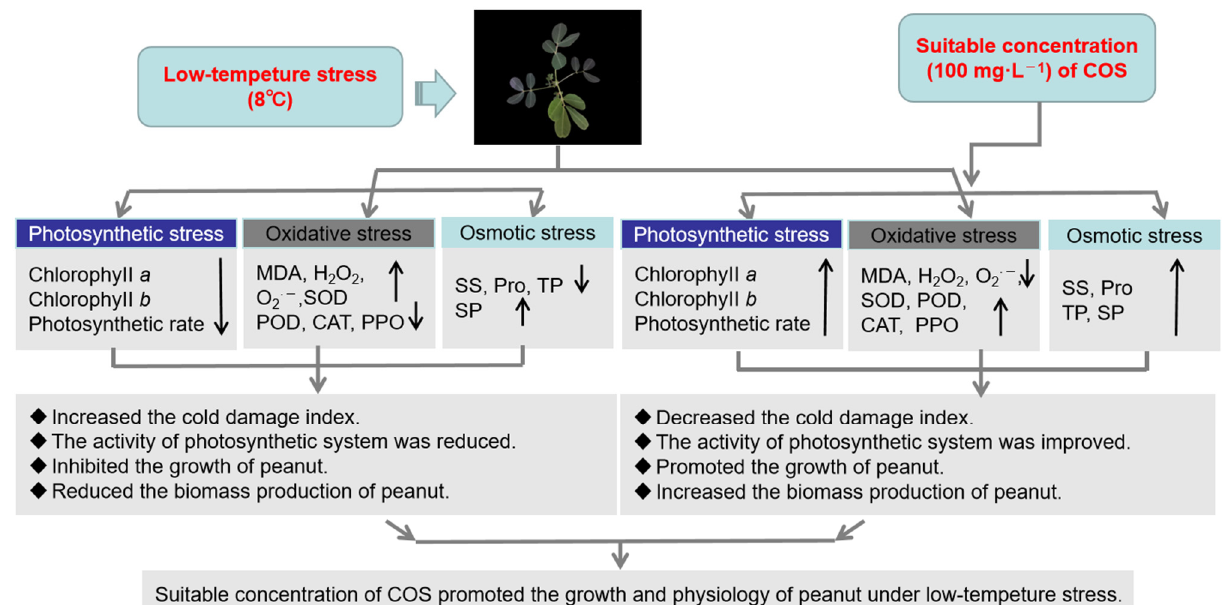
Figure 6. Summary changes of physiological characteristics in peanut at low temperature (8 °C).